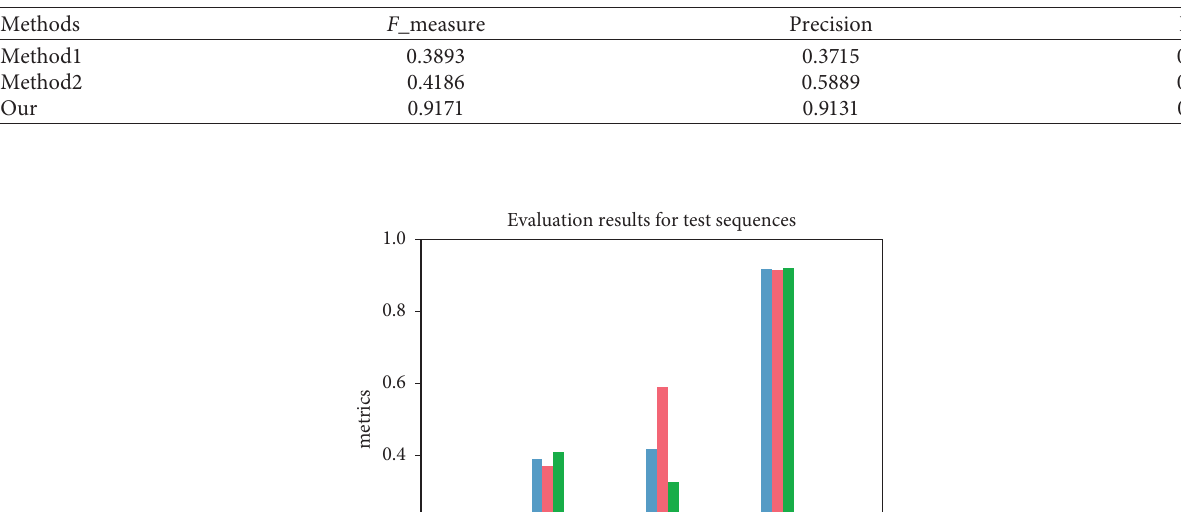
Table 2: Comparison of the metrics for test sequences.